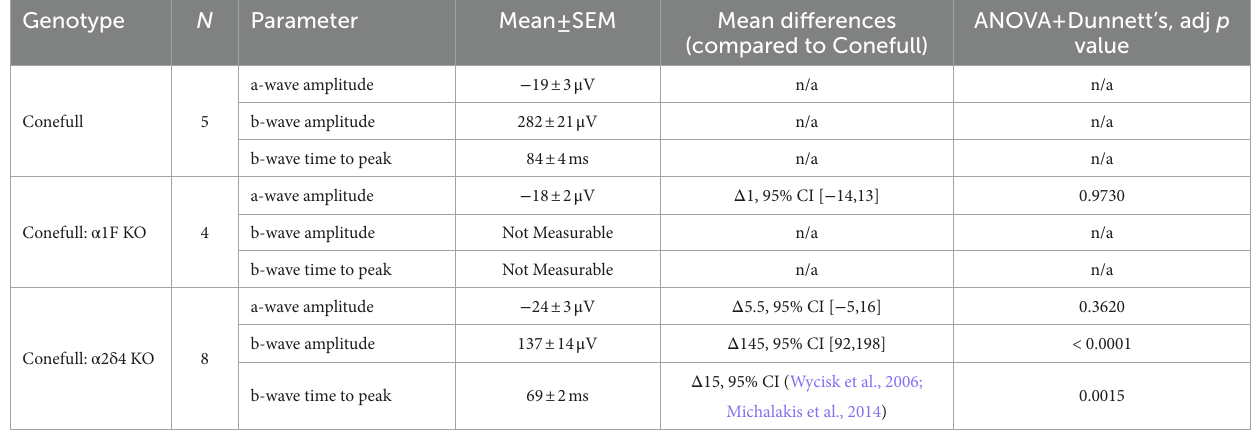
TABLE 2 Statistical description of ERG response to 2.9 log (cd.s/m 2 ) flash on saturating